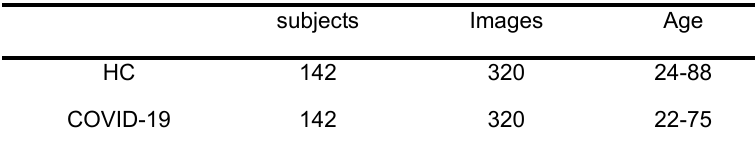
Table 1. Details of the subjects tested in this